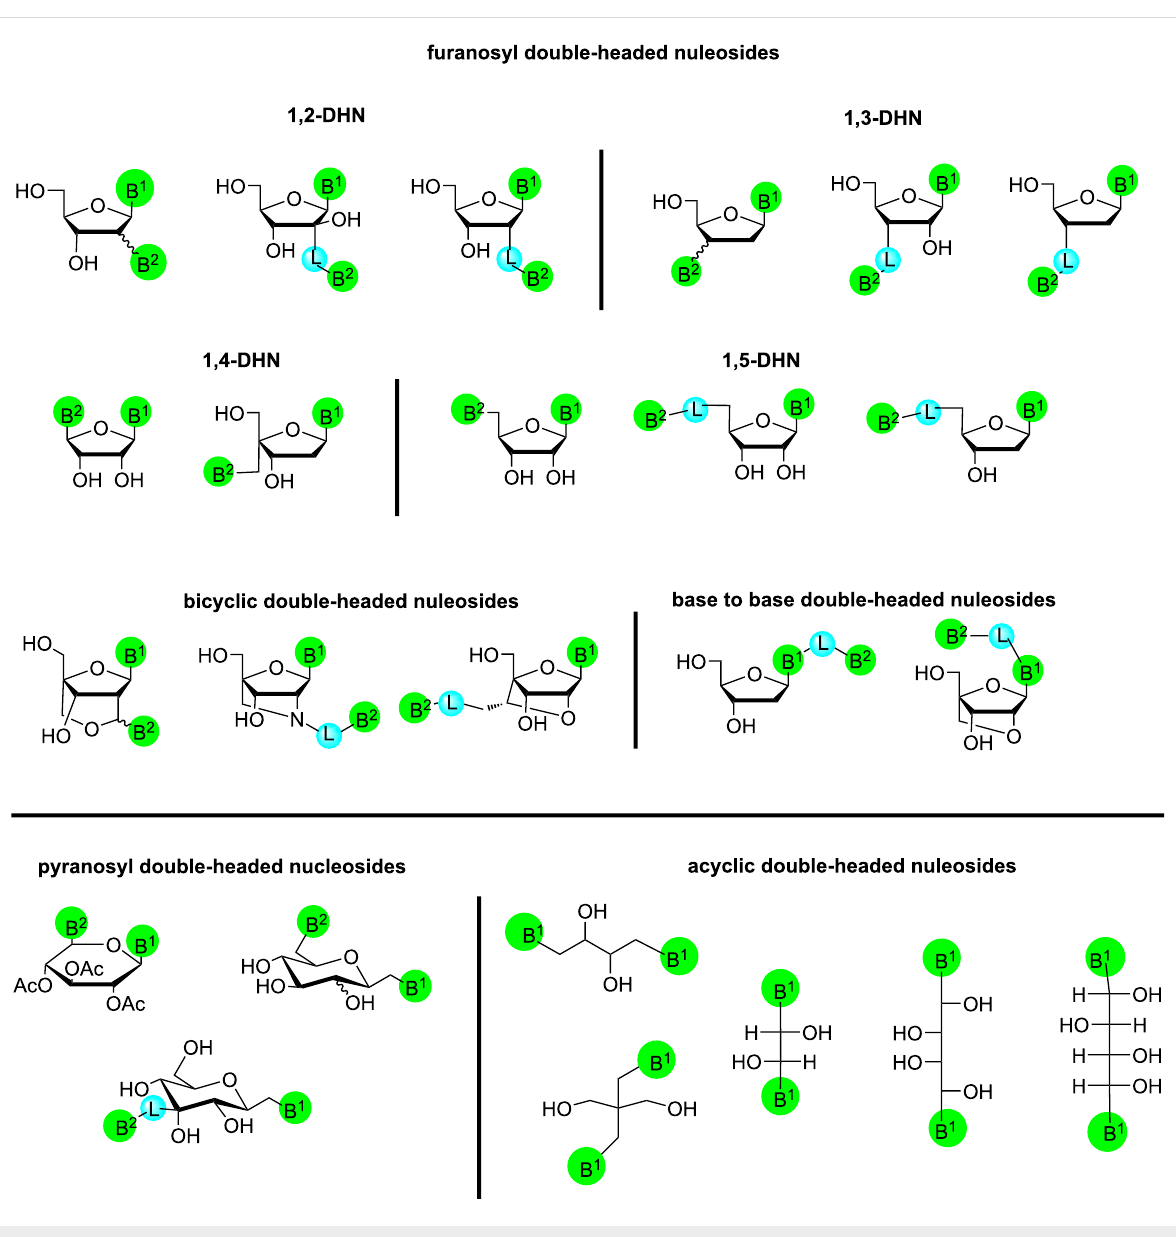
Figure 1: Double-headed nucleosides. B 1 and B 2 = nucleobases or heterocyclic/carbocyclic moieties; L = linker.